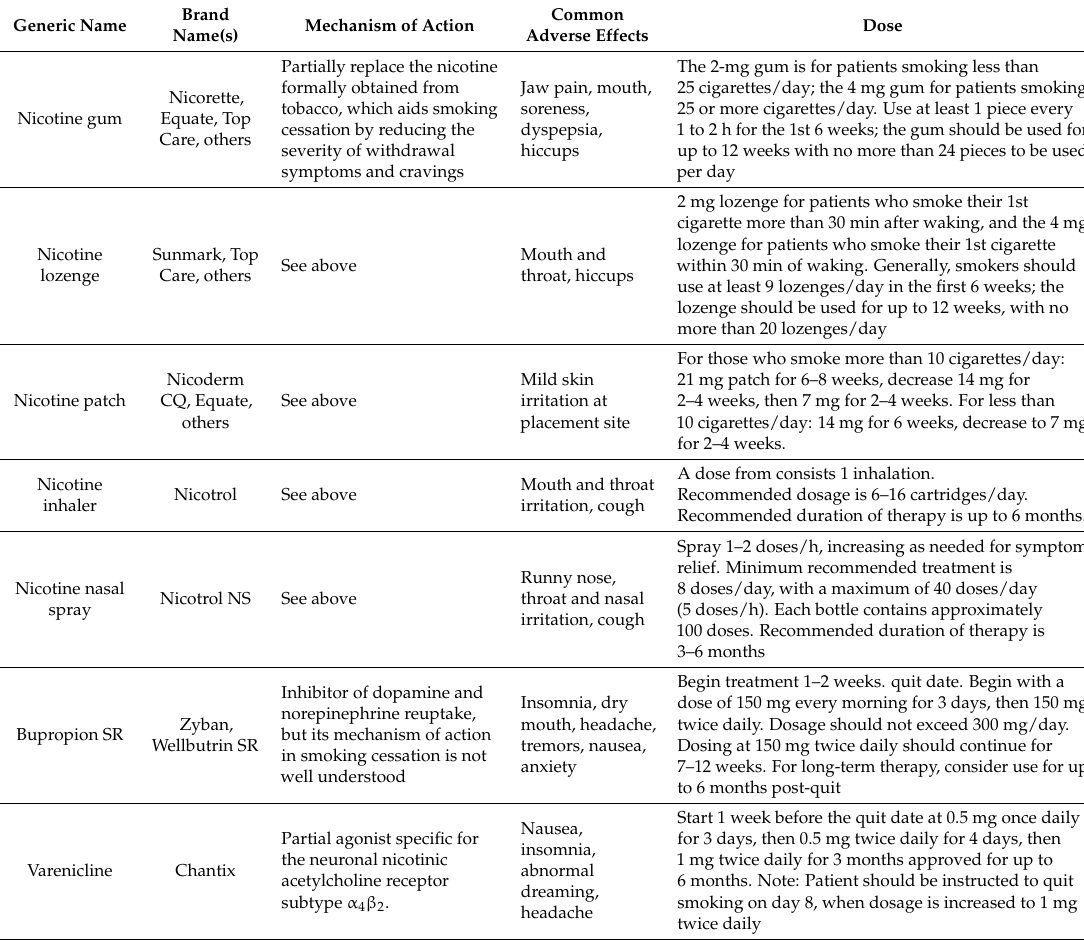
Table 6. Pharmacologic agents for smoking cessation